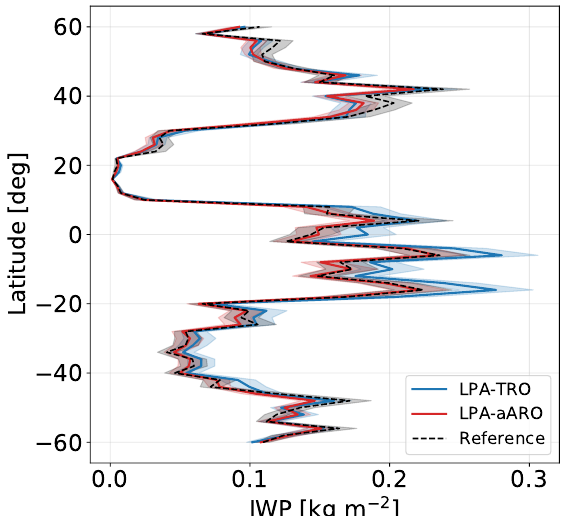
Figure 11. The zonal means of the IWP retrievals based on the LPA-aARO and LPA-TRO databases. The reference (test data) is shown in black. For all three datasets, the shaded region represents the one standard deviation around the mean, calculated by random sampling with replacement (bootstrapping).